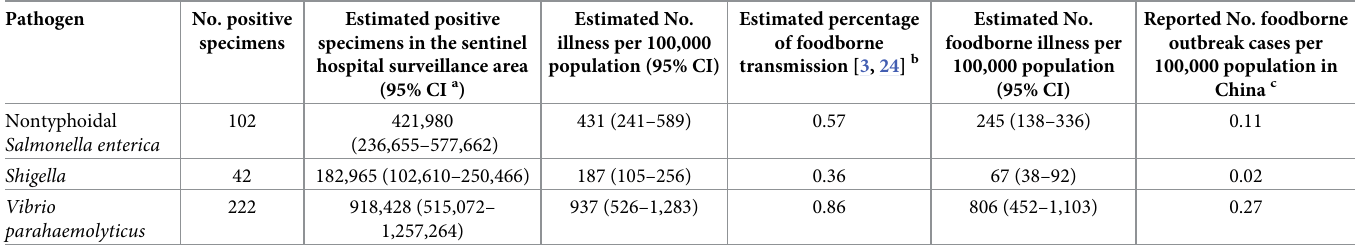
Table 3. Estimated health burden of nontyphoidal Salmonella enterica , Shigella and Vibrio parahaemolyticus gastroenteritis in China, 2010–2011. Pathogen